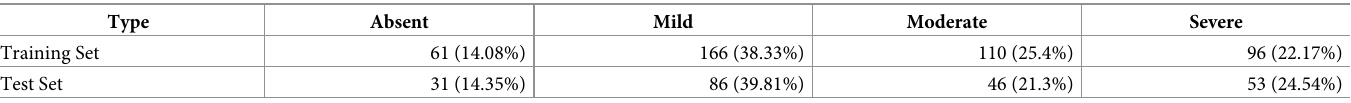
Table 1. Record distribution of the CEGS N-GRID 2016